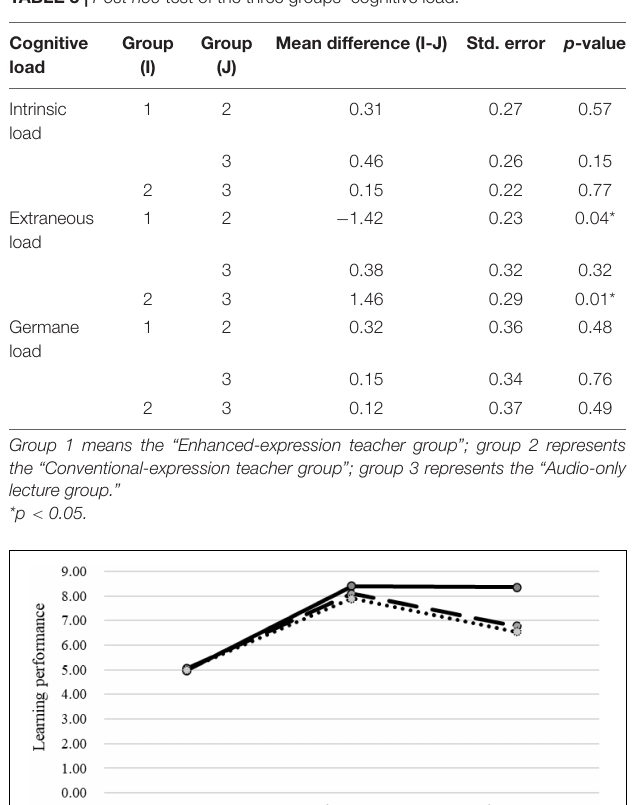
recall in the enhanced-expression teacher group than those in the conventional-expression teacher group ( p < 0.001) and the audio-only lecture group ( p < 0.001) through Bonferroni’s multiple comparison test. No significant difference was found in the long-term recall of the conventional-expression teacher group and the audio-only lecture group ( p = 0.50). The average